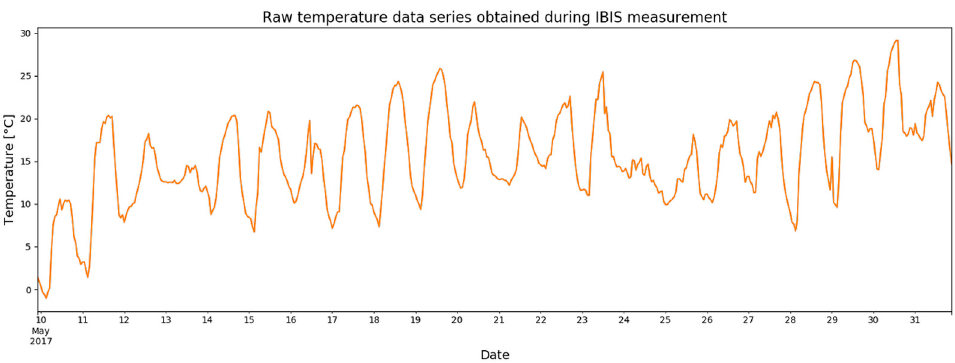
Figure 11. Raw temperature data series obtained during the IBIS measurements.